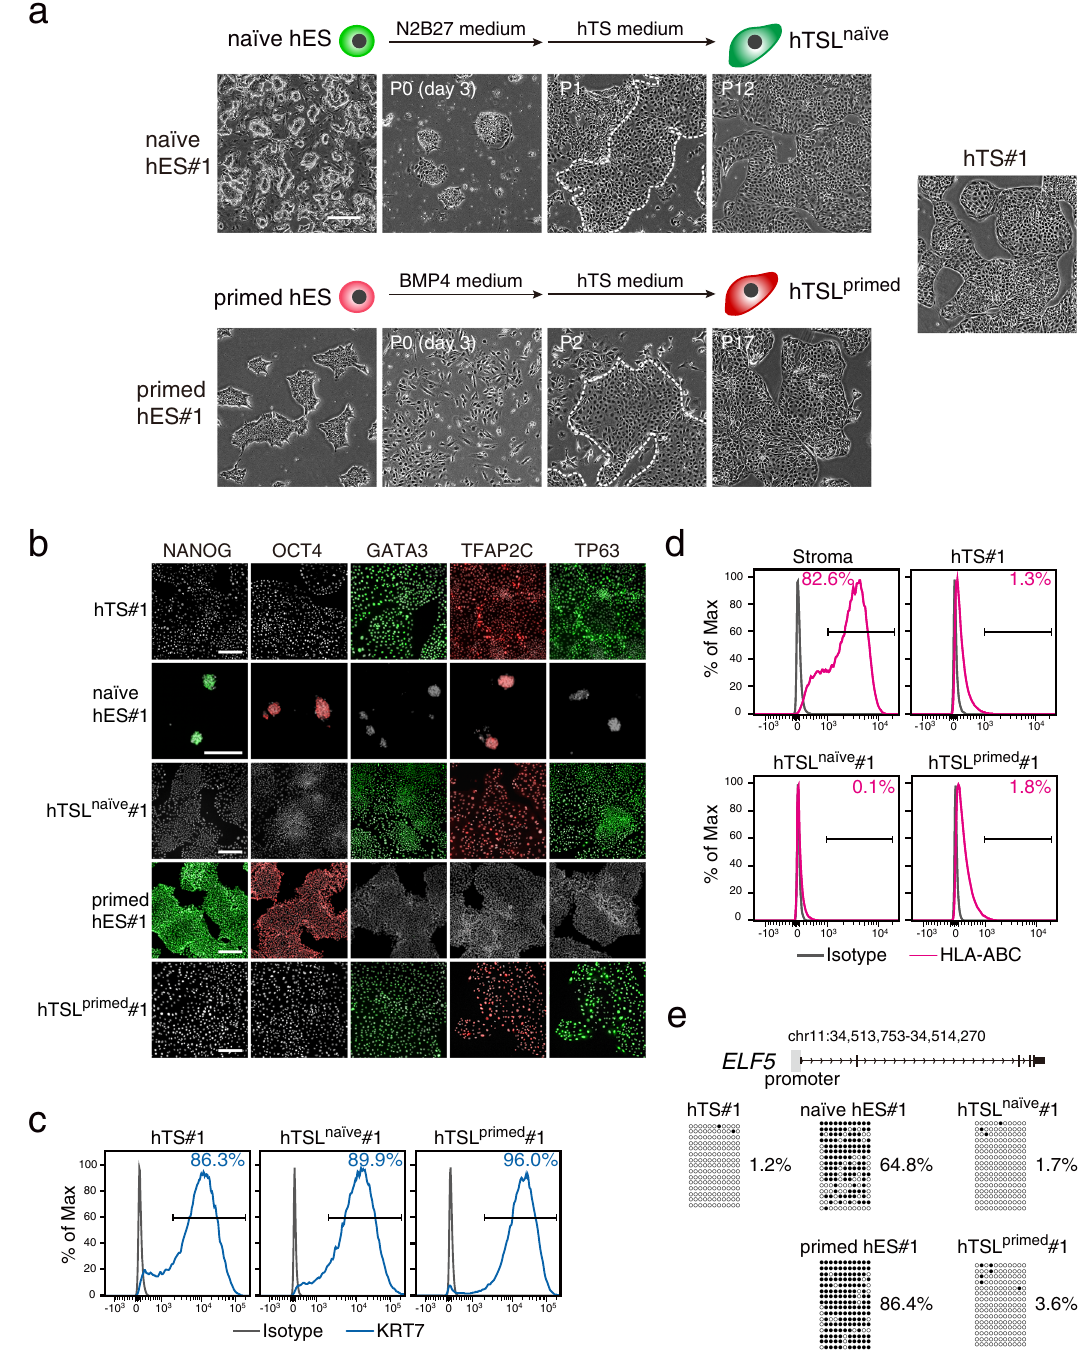
Fig. 1 Derivation of hTSL cells from naïve and primed hES cells. a Phase-contrast images of hTSL cells derived from naïve and primed hES cells. Naïve hES cells were derived from primed hES cells using 5i/L/A medium. After three days of culture in N2B27 medium, naïve hES cells were dissociated and cultured in hTS medium. Primed hES cells were treated with BMP4 for three days and then, the resultant cells were dissociated and cultured in hTS medium. hTSL cells were visible within a few passages (white dotted line). Similar results were obtained with two independent hES cell lines. An image of hTS cells (hTS#1) is shown for comparison. The scale bar indicates 300 μ m. b Immunostaining of pluripotency markers (NANOG and OCT4) and TE-associated transcription factors (GATA3, TFAP2C, and TP63) in hES, hTS, and hTSL cells. Nuclei were stained with Hoechst 33,258 (shown in gray). The scale bar indicates 200 μ m. Similar results were obtained with two independent cell lines. c Flow cytometry analysis of KRT7 expression in hTSL cells. Representative data obtained from two independent cell lines are shown. hTS cells were analyzed as a positive control. d Flow cytometry analysis of HLA-ABC expression on hTSL cells. Representative data obtained from two independent cell lines are shown. Stromal cells isolated from human placentas were analyzed as a positive control. e DNA methylation analysis of the ELF5 promoter by bisul fi te sequencing. Black and white circles indicate methylated and unmethylated CpGs, respectively. The methylation levels are shown on the right. The analyzed region is highlighted by a grey